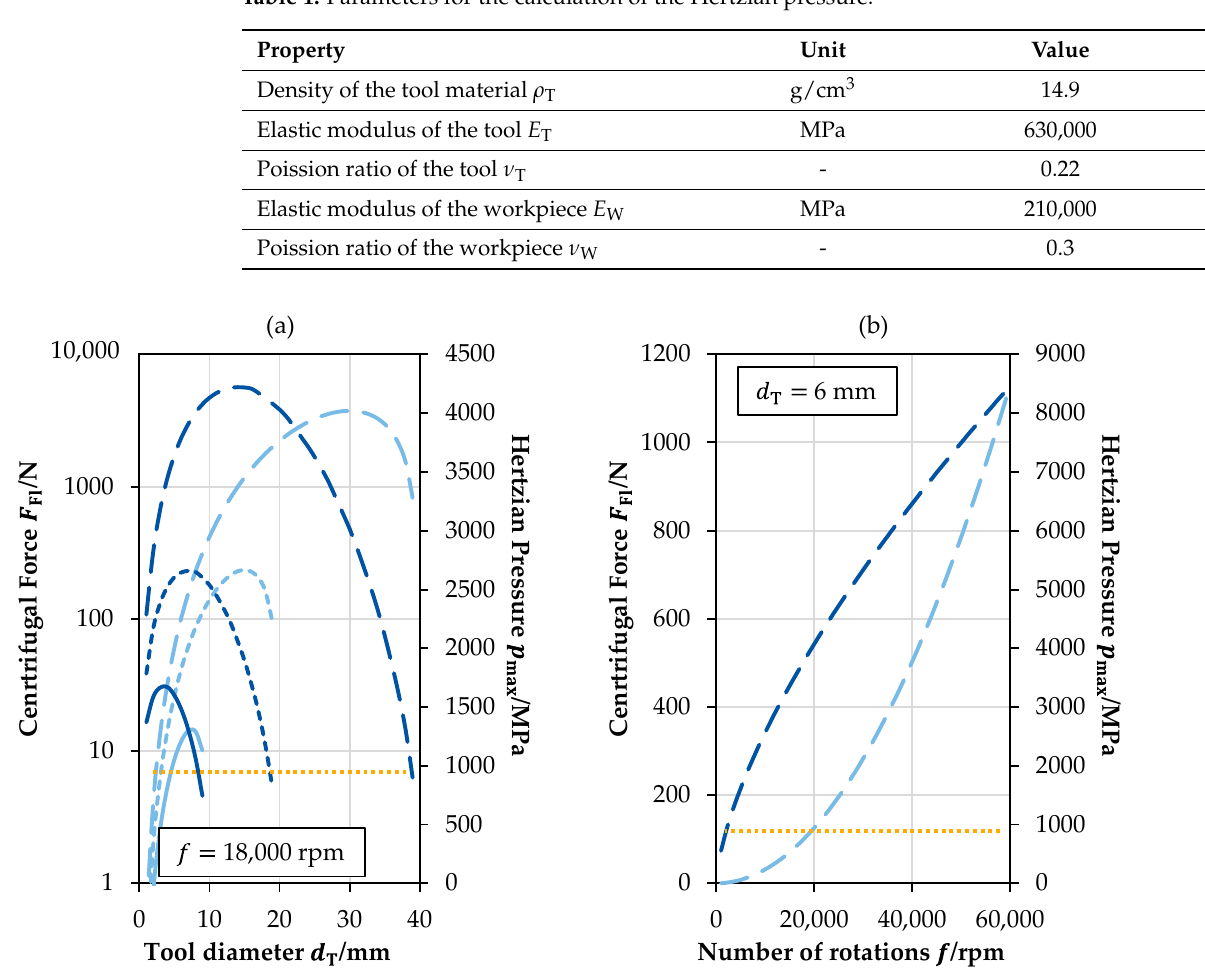
Table 1. Parameters for the calculation of the Hertzian pressure.